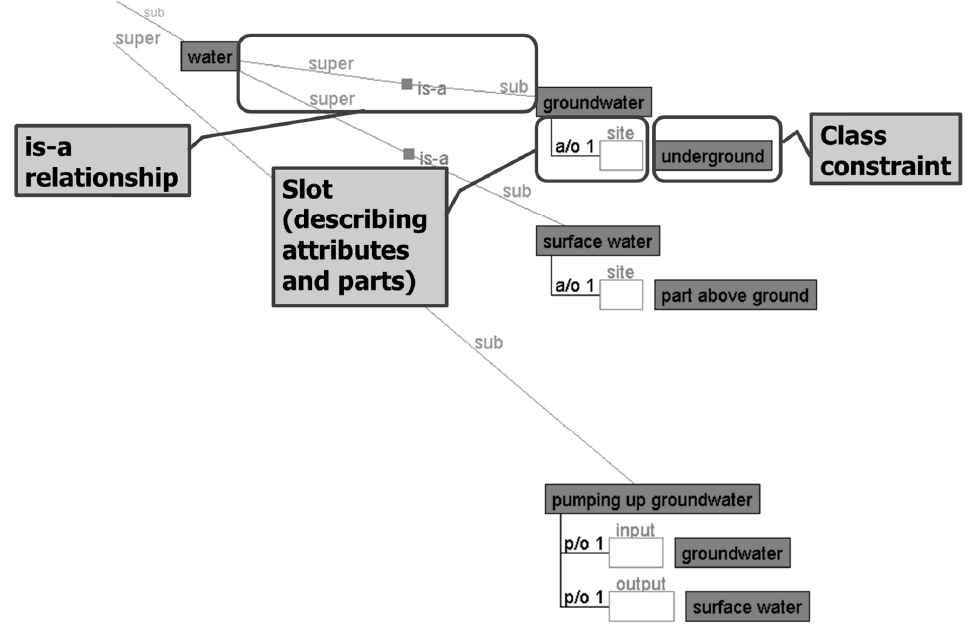
Figure 2. An example of concept definition based on ontology engineering.